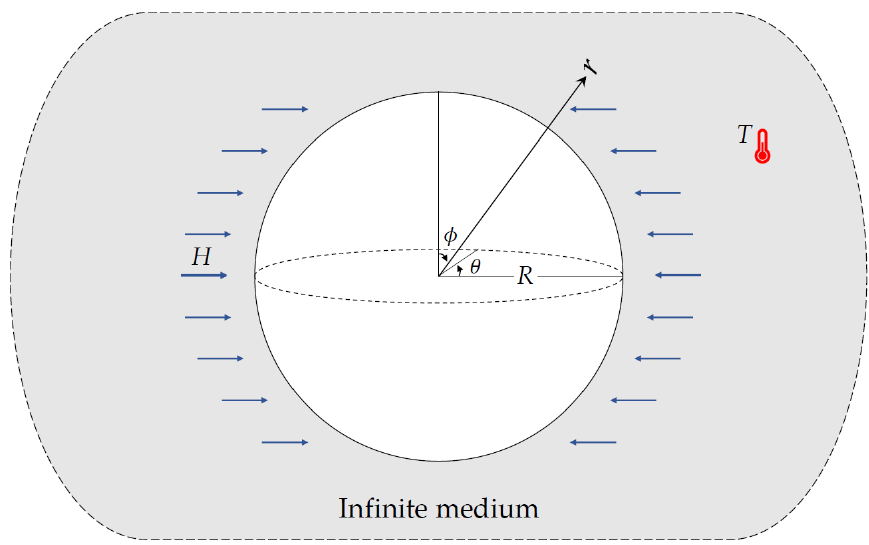
Figure 1. A spherical cavity in an unbounded medium under harmonically varying heat and external magnetic field.